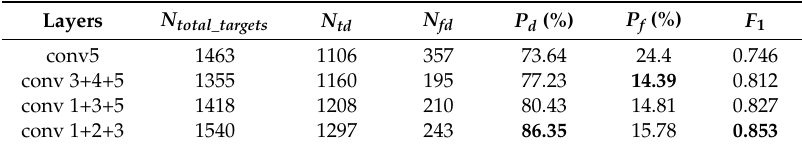
Table 1. Detection performance with different layer combination